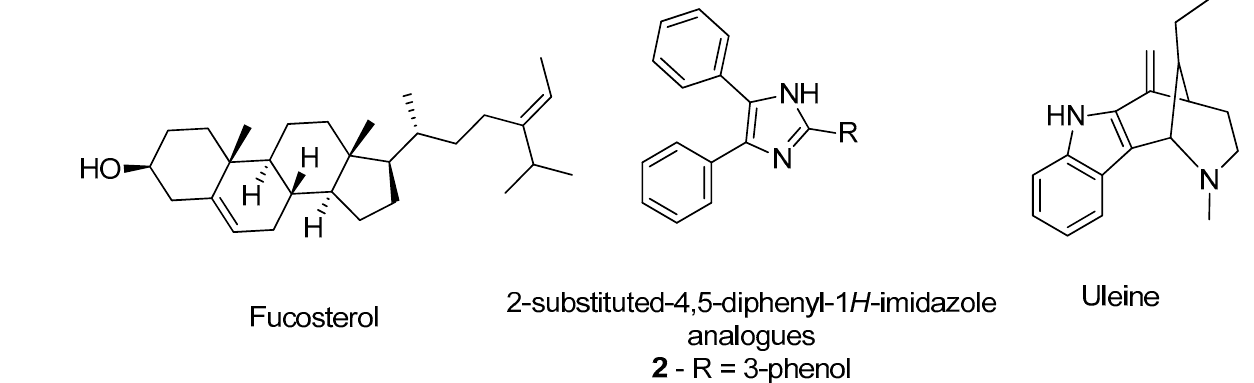
Figure 3. Structure of the studied AChE inhibitors.